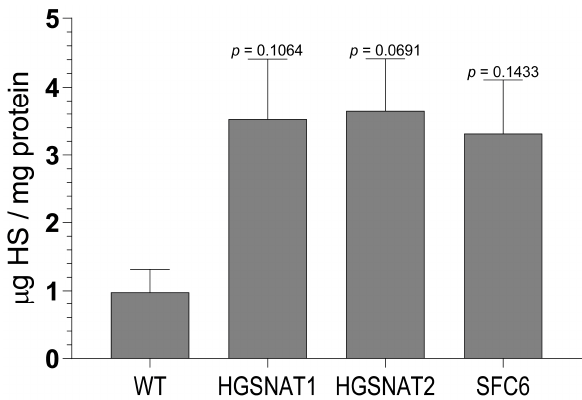
Figure 4. LAMP2 analysis in iNs. ( A ) Representative images of iNs after 10 days of differentiation positive for LAMP2 (green) and Tuj1 (red). DAPI was used to detect nuclei (blue). Scale bar = 10 µm. ( B ) Quantification of the lysosomal content shown as LAMP2+ coverage of the Tuj1+ neuronal soma. ( C ) Fold change in the mean LAMP2 dot intensity in disease iNs normalized to mean intensity of LAMP2 in WT-iNs. Data are shown as the mean ± s.e.m. from three independent experiments with five technical replicates. ** p value < 0.01, ordinary one-way ANOVA corrected by Dunnett post hoc test, comparing all groups to WT.